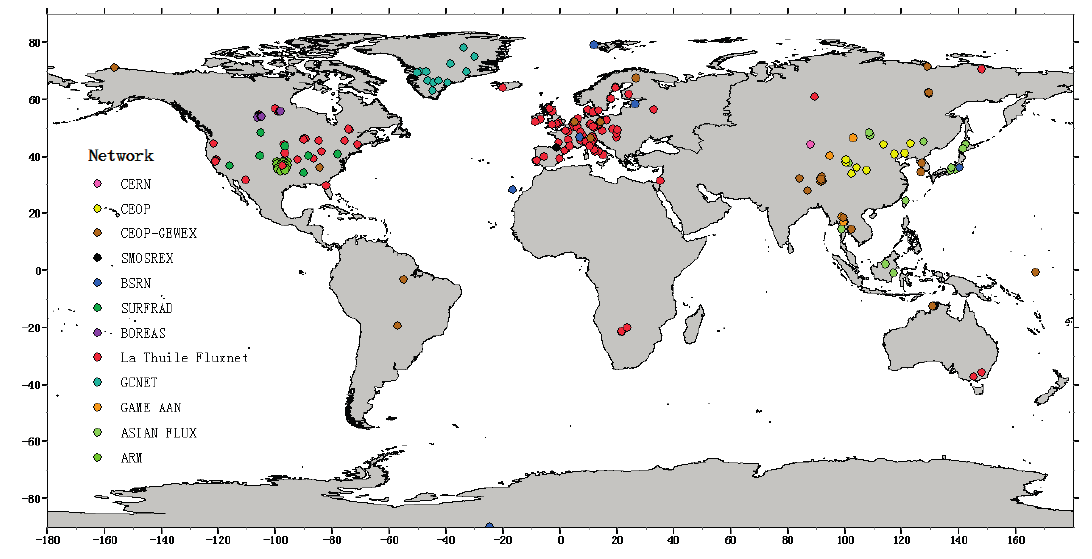
Figure 1 Distribution of 251 observing sites in 12 measurement